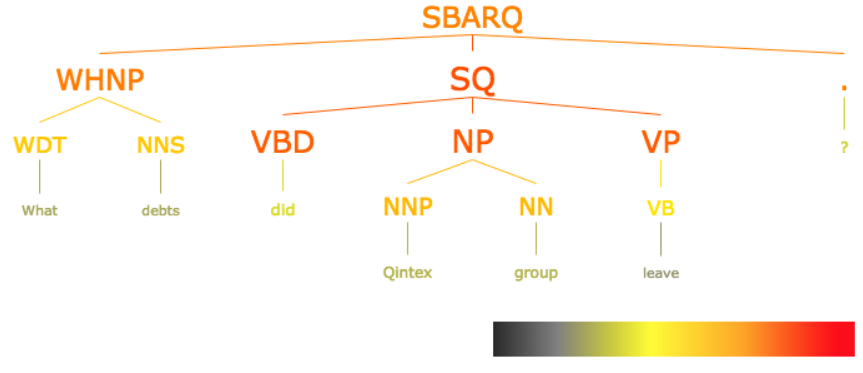
Figure 1. A heat parse